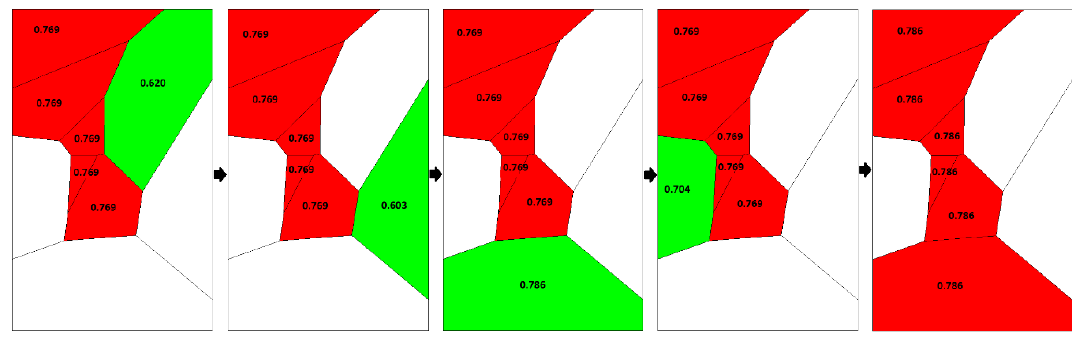
Figure 3. The polygon adjacency algorithm.